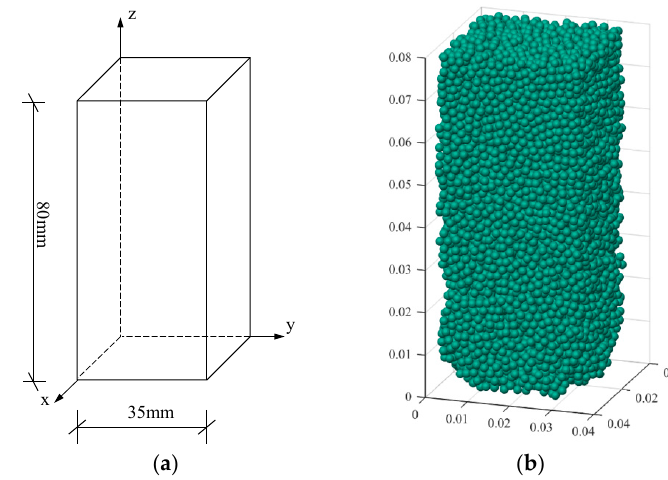
Figure 10. Axial stress-strain curve in triaxial test with 150 kPa confining pressure.